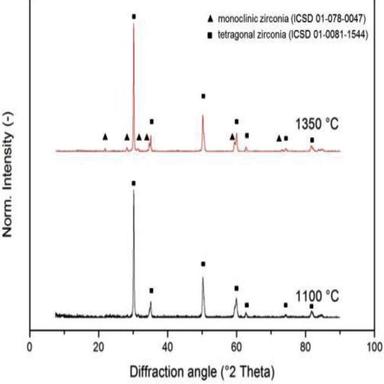
X-ray diffraction pattern of the 3Y–Zr fibers sintered with a heating rate of 10 K/min a) 1100 °C and b) 1350 °C.